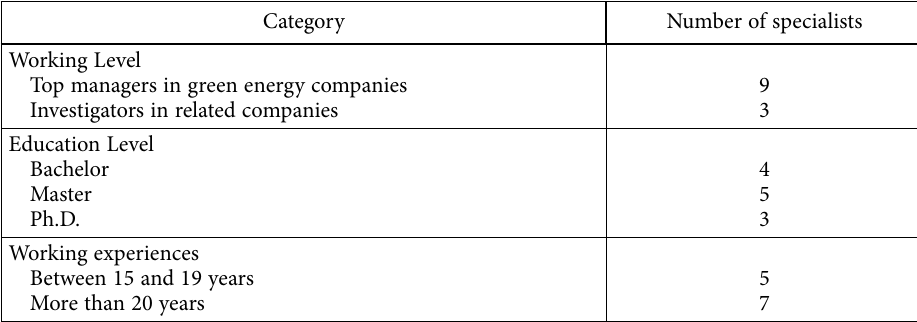
Table 3. These specialists’ background